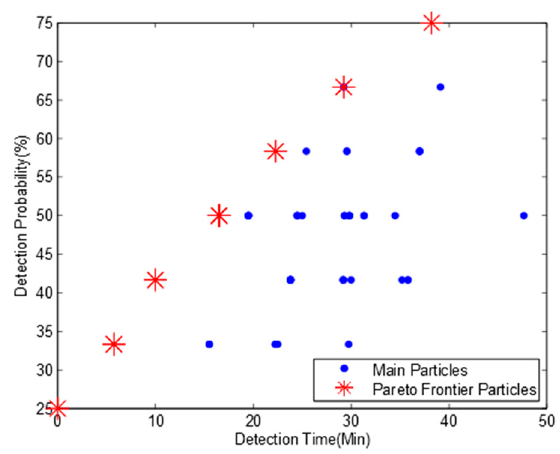
Figure 5. Pareto frontier for river network B with three monitoring nodes and a detection threshold of 0.01 mg/L. Table 5. Optimal deployment solutions on Pareto frontier for river network B with a detection threshold of 0.01 mg/L.